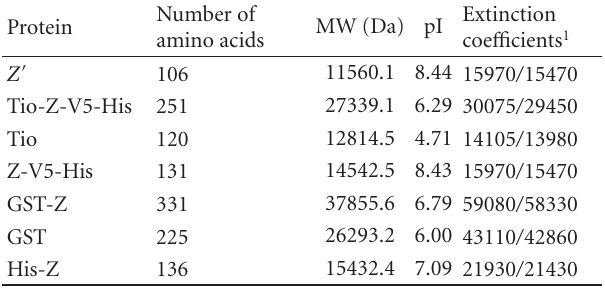
Table 1: Biochemical properties of the di ff erent expressed proteins.